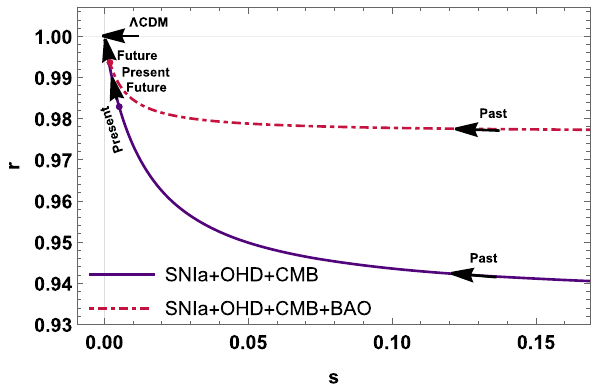
Fig. 6 The statefinder evolutionary trajectory for interacting THDE in the r − s plane for the best estimated values of the model parameters using the fourth and sixth